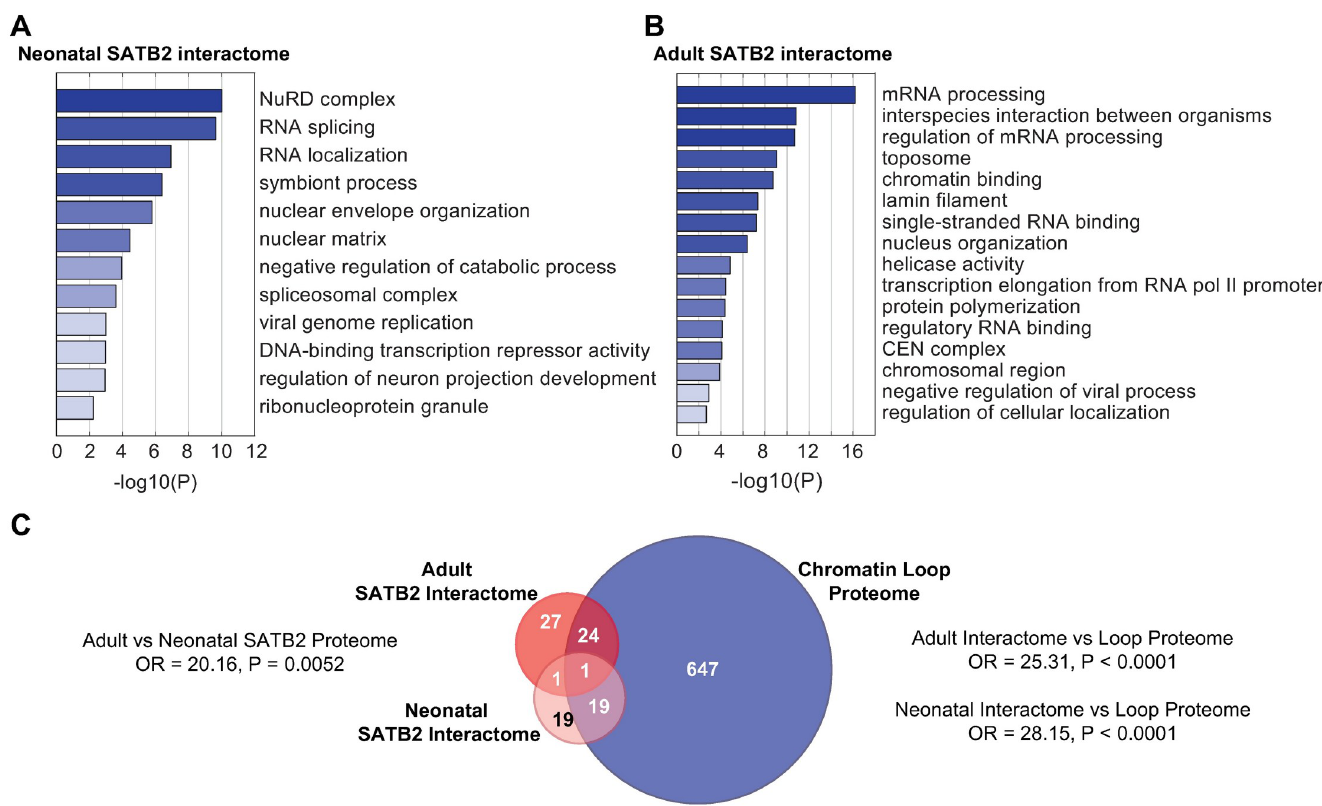
Fig 3. Functional enrichment analysis of SATB2 interactors. (A) Metascape enrichment analysis of neonatal cortex SATB2 interactome. (B) Metascape enrichment analysis of adult cortex SATB2 interactome. Shown are heatmaps of enriched terms across input protein lists, colored by p-values. (C) Venn diagram depicting the overlap between neonatal cortex SATB2 interactome, adult cortex SATB2 interactome, and proteins differentially enriched at stable chromatin loops [23] (Fischer’s exact test, adult interactome vs loop proteome, OR = 25.31, P < 0.0001; neonatal interactome vs loop proteome, OR = 28.15, P < 0.0001; neonatal vs adult proteome (including SATB2 itself), OR = 20.16, P = 0.0052; neonatal vs adult proteome (excluding SATB2 itself), OR = 10.08, P = 0.0984; background, 19 626 protein-coding genes). OR, odds